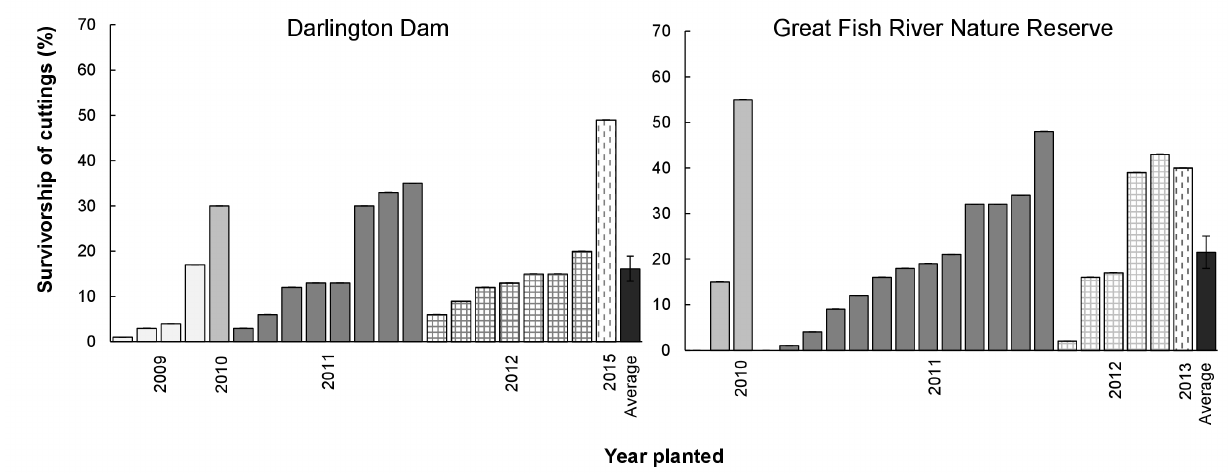
Figure 6. Percentage survivorship of spekboom cuttings planted in different years at sites in the Eastern Cape, South Africa. Darlington Dam (within the Addo Elephant National Park) is ~85 km SE of Jansenville. Great Fish River Nature Reserve is ~85 km NE of Grahamstown. Both sites were planted at a density of 2500 cuttings per hectare. Survivorship data were recorded in 2015 from 21 plots (20 m by 20 m). Average percentage survivorships (+ standard error) in Darlington Dam and Great Fish River Nature Reserve, respectively, are indicated by solid black